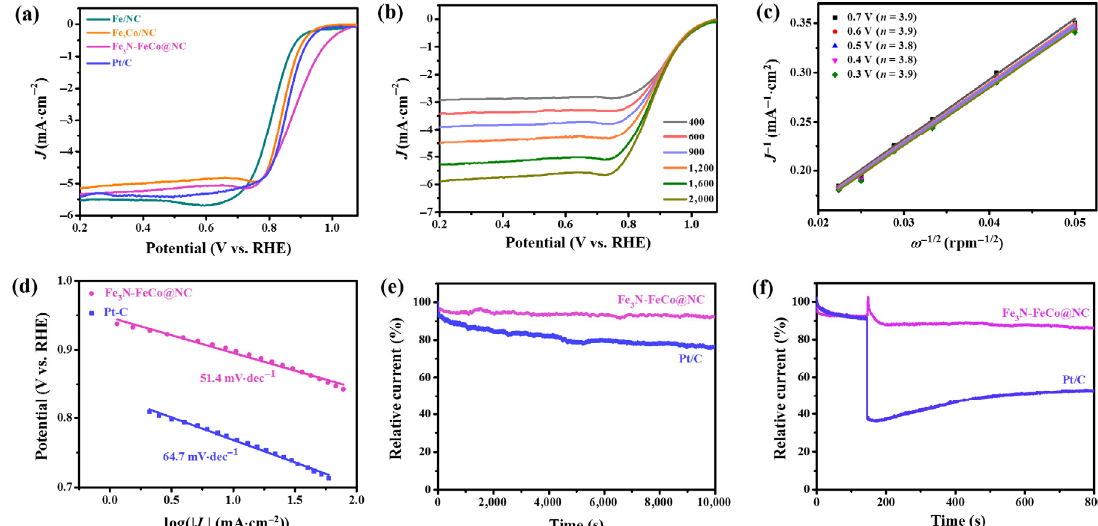
Figure 4 ORR performance of Fe 3 N-FeCo@NC in 0.1M KOH: (a) LSV polarization curves of Fe 3 N-FeCo@NC, and the reference samples of Fe/NC, Fe,Co/NC and Pt/C at 1,600 rpm; (b) LSV polarization curves of Fe 3 N-FeCo@NC at various speeds; (c) K−L plots and the corresponding electron transfer numbers at different potentials; (d) Tafel slopes of Fe 3 N-FeCo@NC, and Pt/C; (e) chronoamperometric response ( i – t ) and (f) methanol resistance of